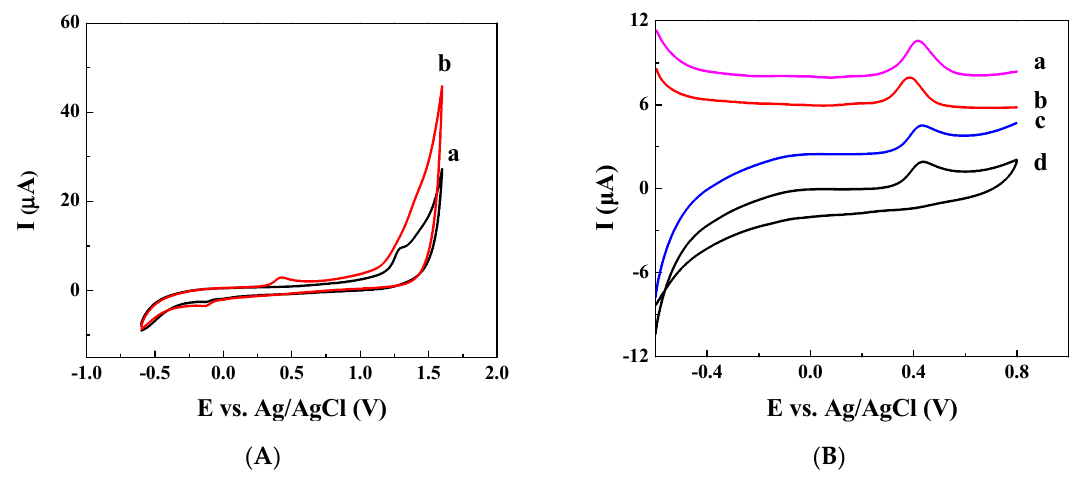
Figure 1. ( A ) Cyclic voltammetry (CV) curves of 25 μ M carbaryl (CBL) in 0.1 M phosphate-buffered saline (PBS, pH 7.0) before (a) and after (b) hydrolysis. ( B ) Square wave voltammetry (SWV) (a), differential pulse voltammetry (DPV) (b), linear sweep voltammetry (LSV) (c), and CV (d) curves of 25 μ M CBL in 0.1 M PBS (pH 7.0) after hydrolysis.